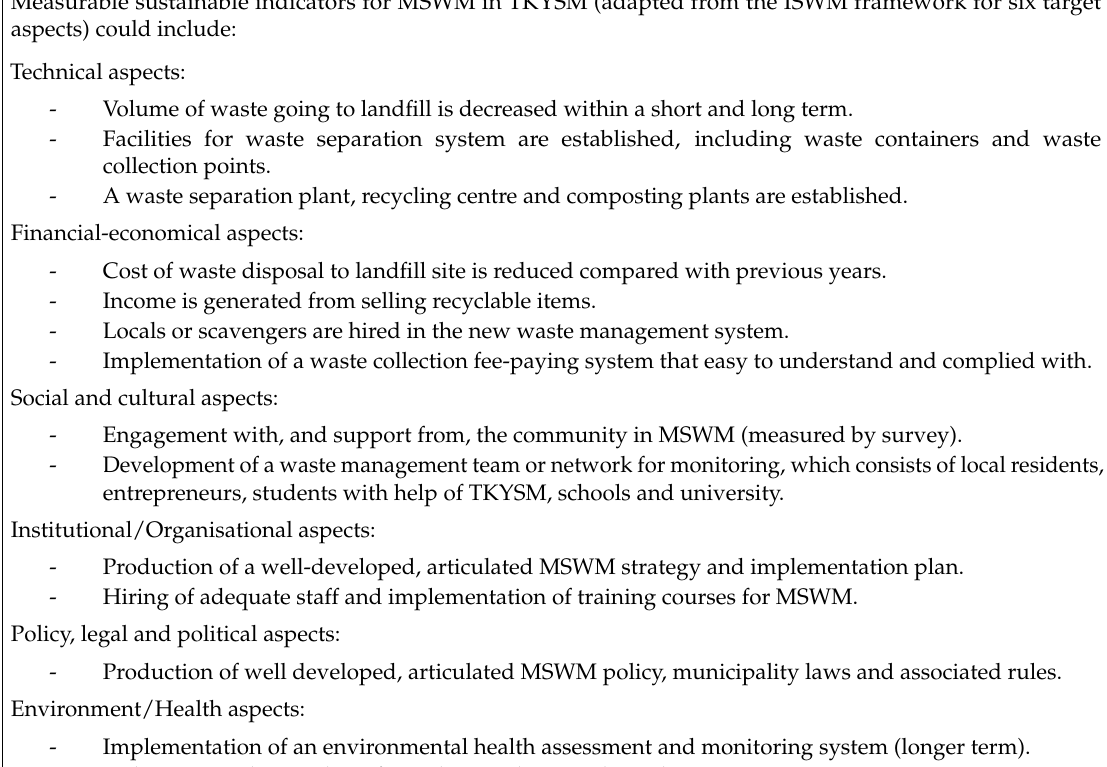
Box 1. Measurable sustainable indicators for MSWM in